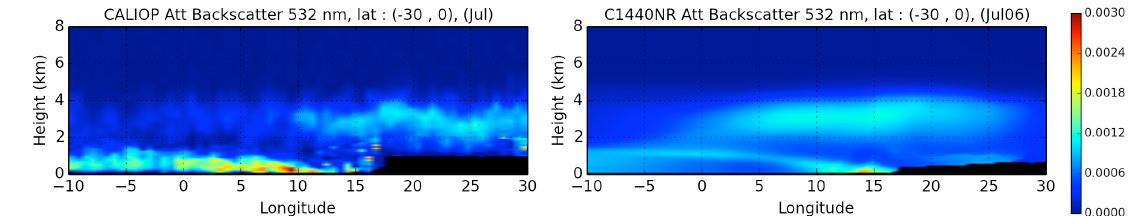
Figure 8: Same as Figure 7 but for the southern Africa biomass burning region (10°W – 30°E, 0°S – 30°S). Figure 6. Same as Figure 5 but for the southern Africa biomass burning region (10 ◦ W – 30 ◦ E, 0 ◦ S – 30 ◦